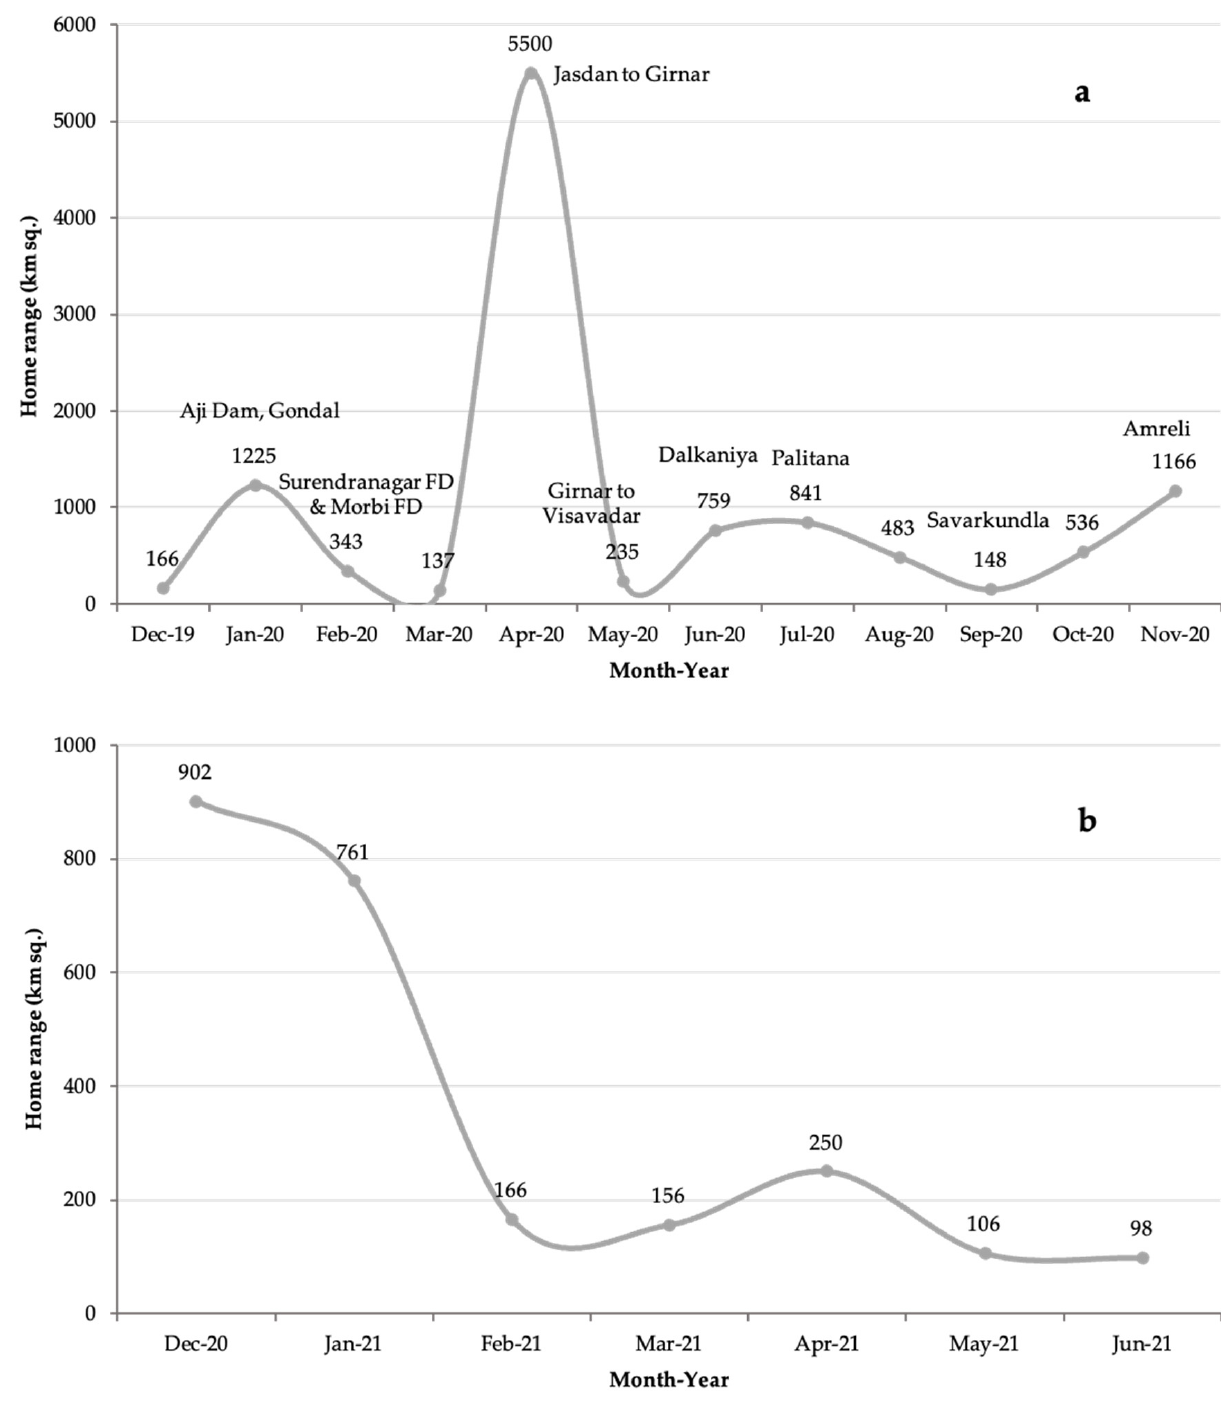
Figure 4. The home range (100% minimum complex polygon) of sub-adult Chotila males and coalition partners. ( a ) Home range during the nomadic stage from December 2019 to 20 November 2020; ( b ) home range during the post-nomadic phase from December 2020 to June 2021.